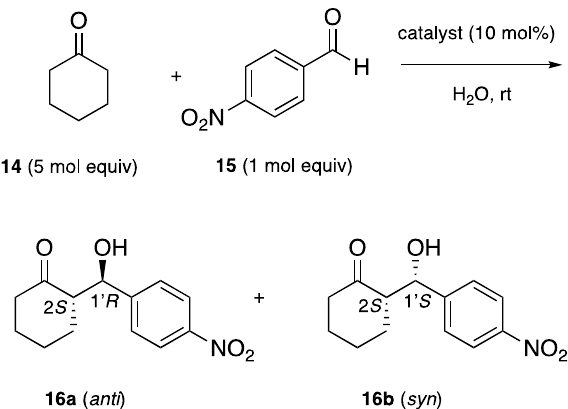
Scheme 6. Aqueous aldol reaction of cyclohexanone 14 with 4-nitrobenzaldehyde 15